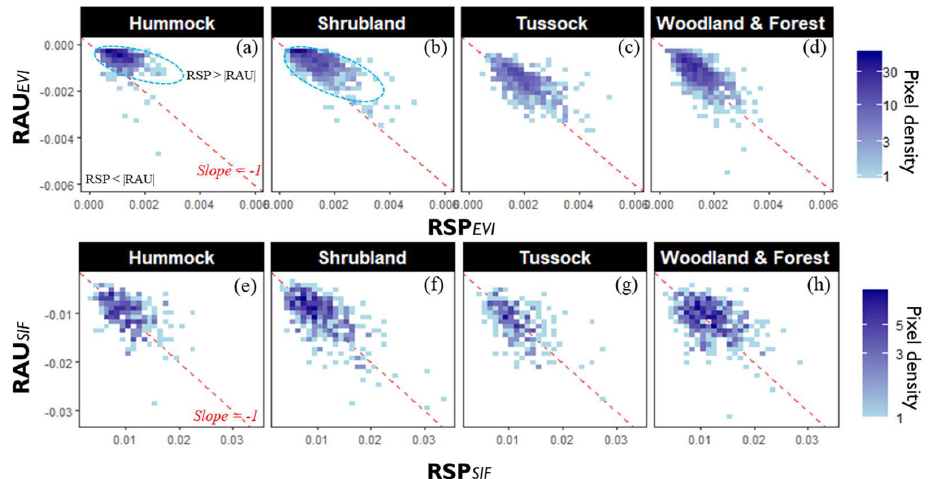
Figure 7. Scatter plot between spring green-up rates (RSP) and autumn senescence rates (RAU) of ( a – d ) EVI and ( e – h ) SIF among four major biomes across the entire study region. Red dashed lines refer to a − 1:1